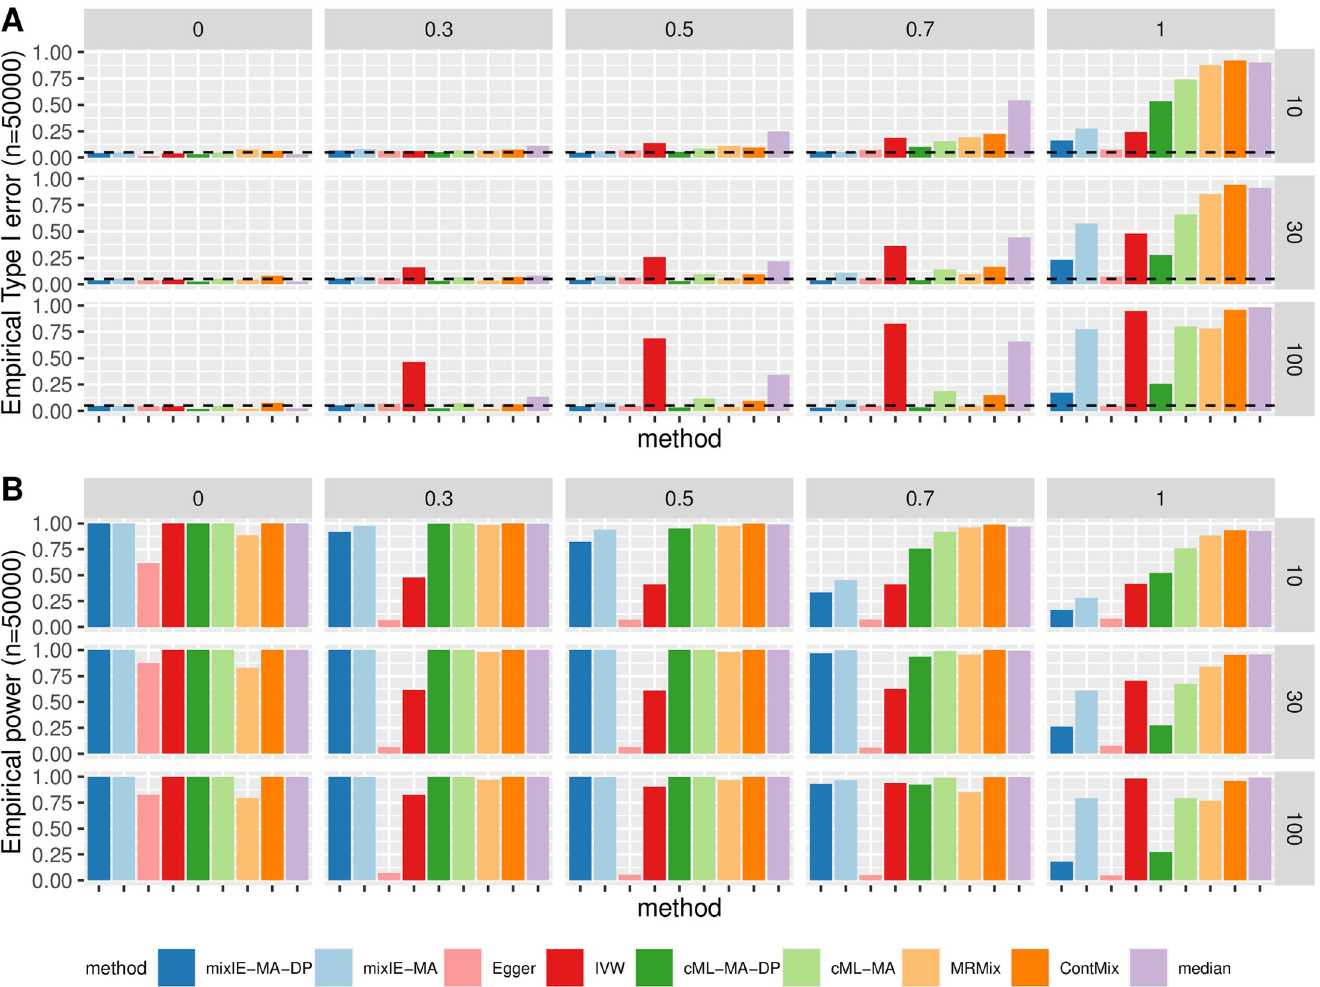
Fig 2. Simulation results with directional pleiotropy and InSIDE satisfied. A: Empirical type-I error; B: Power with sample size n = 50 000. Each row corresponds to m = 10, 30, 100 SNPs and each column corresponds to 0, 30%, 50%, 70%, 100% invalid IVs.